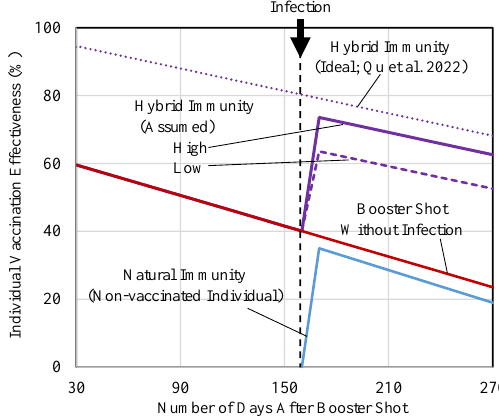
Figure 2. Waning immunity of booster with and without previous SARS-CoV-2 infection. Table 1. Parameters for the individual VE used in Equation (1).